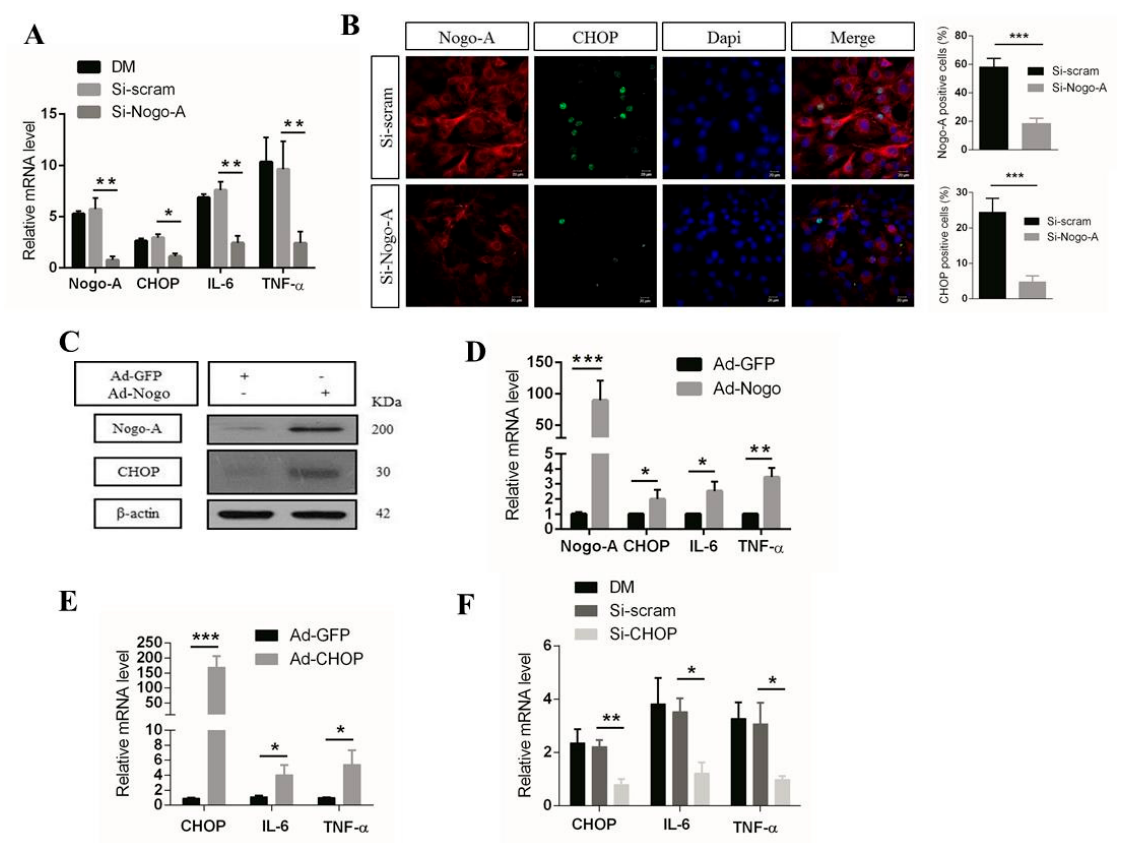
Figure 1. Nogo-A enhances CHOP expression and production of pro-inflammatory factors in C2C12 cells. ( A ) C2C12 cells were transfected with small interfering (si)-Nogo-A or si-scramble, after which the cells were differentiated (DM) for 3 days and then harvested for qPCR analysis of Nogo-A, CHOP, IL-6, and TNF- α expression levels. ( B ) Nogo-A and CHOP antibodies were used to stain transfected C2C12 cells for immunofluorescence (IF) analysis. ( C ) Cell extracts were analyzed by immunoblot (IB) analysis for Nogo-A, CHOP, and β -actin expression. ( D ) C2C12 cells were infected with adenovirus plasmid encoding green fluorescent protein (Ad-GFP) and Ad-Nogo-A (60 multiplicity of infection (MOI)) for 24 h. Nogo-A, CHOP, IL-6, and TNF- α mRNA levels were analyzed by qPCR. ( E ) Ad-GFP and Ad-CHOP (60 MOI) were used to infect C2C12 cells for 24 h. qPCR analysis of CHOP, IL-6, and TNF- α expression. ( F ) C2C12 cells were transfected with si-CHOP or si-control. After transfection for 36 h, the cells were differentiated for 3 days and then qPCR was performed to determine CHOP, IL-6, and TNF- α expression. In all, 40 µ g of protein was used for IB. Data are shown as the mean ± standard error of the mean. Statistical significance was determined using Student’s t -test. The β -actin level was used for normalization of the expression levels. Data are denoted by asterisks where * p < 0.05, ** p < 0.01, *** p < 0.001. Alexa Fluor (AF)-488 and AF-555 were used as secondary antibodies. Scale bar, 10 µ m, × 400